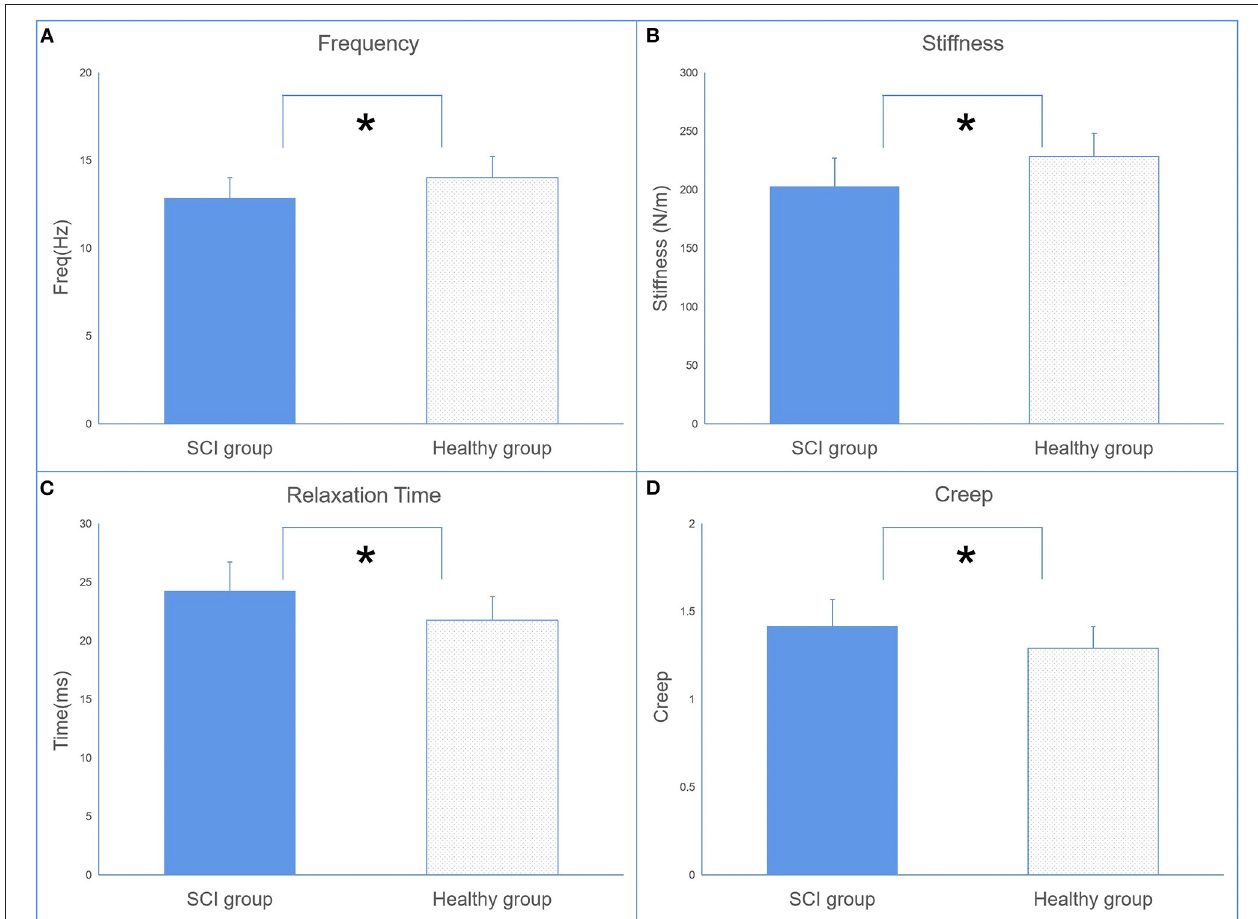
FIGURE 2 | The comparisons of muscle mechanical properties [oscillation frequency (A) , dynamic stiffness (B) , mechanical stress relaxation time (C) , and indication of creep (D) ] between the SCI and control groups (mean ± SD, * indicates p < 0.05 between groups).